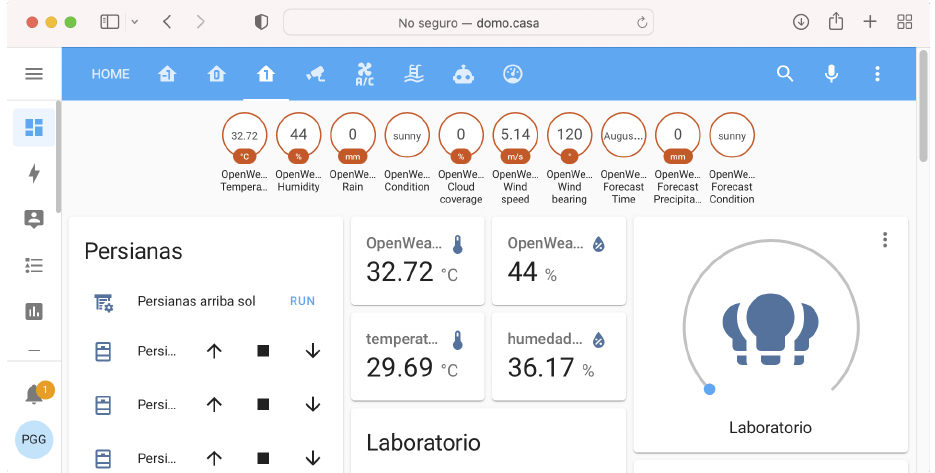
Figure 12. Test-bed’s Home Assistant installation graphical